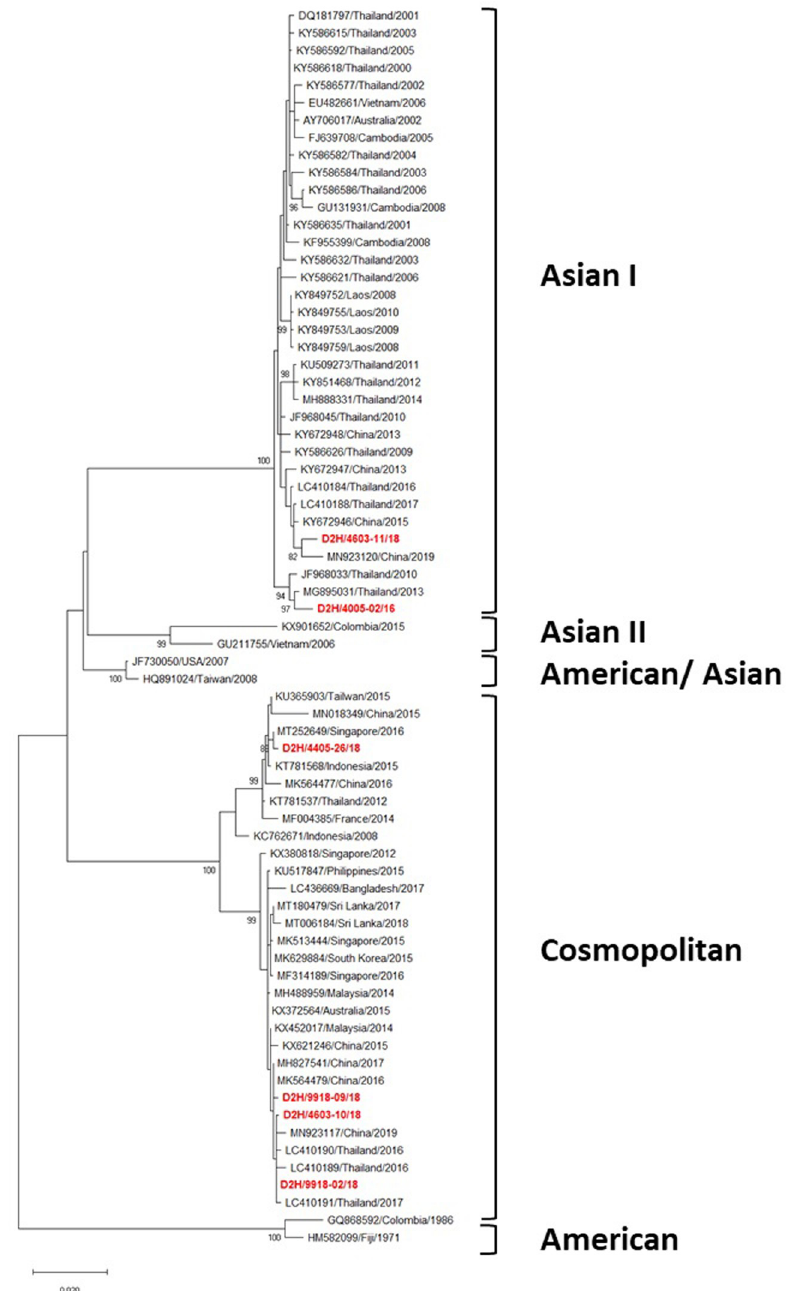
Fig 4. Phylogenetic analysis of DENV-2. Maximum-likelihood tree of the E gene sequences of DENV-2 was generated in the MEGA X program using the TN93 + G model with 1000 bootstrap replications. Bootstrap support values exceeding 80% are shown on branch nodes. The virus names of each sequence retrieved from the NCBI database are labeled as follows: GenBank accession number/country/isolated year. Samples collected in the present study are in bold red font. Annotation on the right denotes DENV